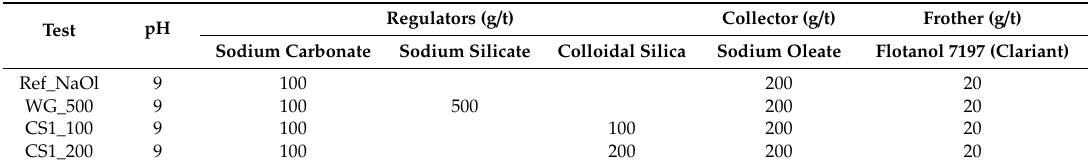
Table 2. Batch flotation reagent regime.